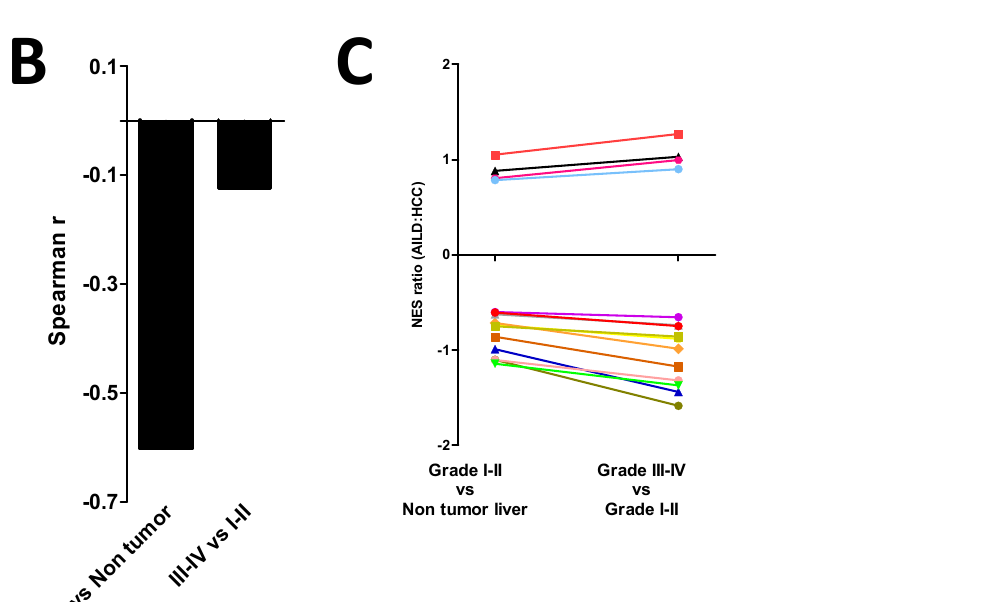
Figure 4. Histological signs of HCC are imperfect correlates of AILD associated HCC signatures. ( A ) 2D scatter plots depicting the enrichment scores of transcription factor modules along AILD vs. healthy liver ( x axis) and advanced stage vs. previous stage of HCC ( y axis) comparisons for different HCC etiology groups. Enrichment scores were obtained following GSEA against “TF.Target.ENCODE” database on iDEP.91. Moving rightwards along the x axis indicates increased expression in AILDs and moving upwards along the y axis indicates increased expression in HCC. ( B ) Spearman rank correlation coefficient between AILD and HCC for each stage of Edmondson–Steiner grading. ( C ) kinetics of shift in NES ratio between AILD and HCC for each transcription factor module across all stages of HCC. The color and signs of each transcription factor module (for A , C ) are shown at the right side of ( C ).